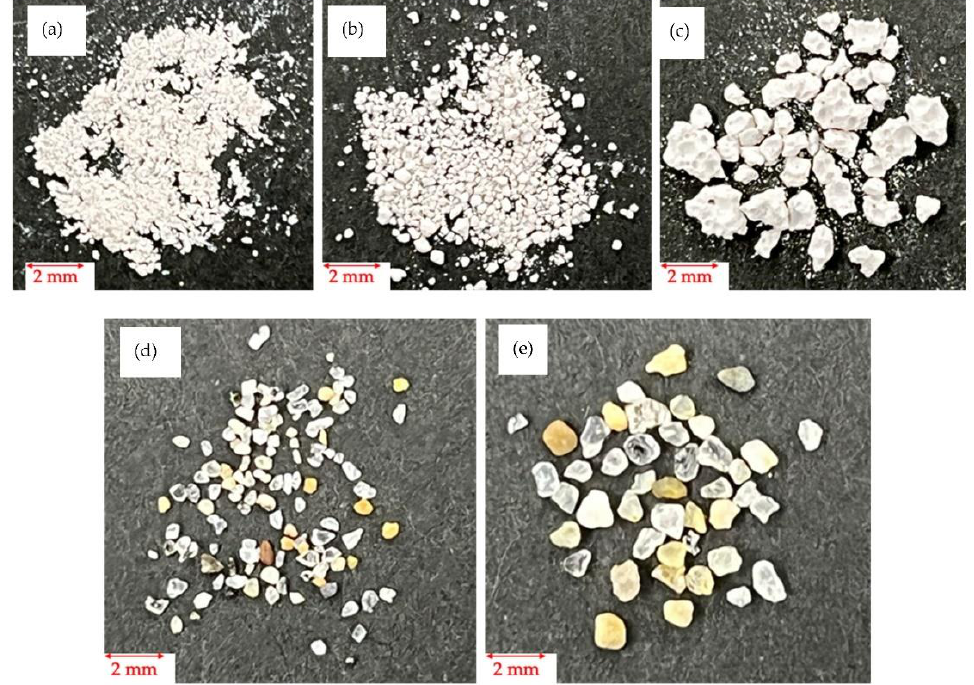
Figure 1. Samples: ( a ) VN-AAC (Grain size: 0.106–0.25 mm); ( b ) VN-AAC (Grain size: 0.25–0.85 mm); ( c ) VN-AAC (Grain size: 0.85–2.00 mm) ( d ) Sand (Grain size: 0.18–2.00 mm); ( e ) Sand (Grain size: 0.30 – 2.00 mm).